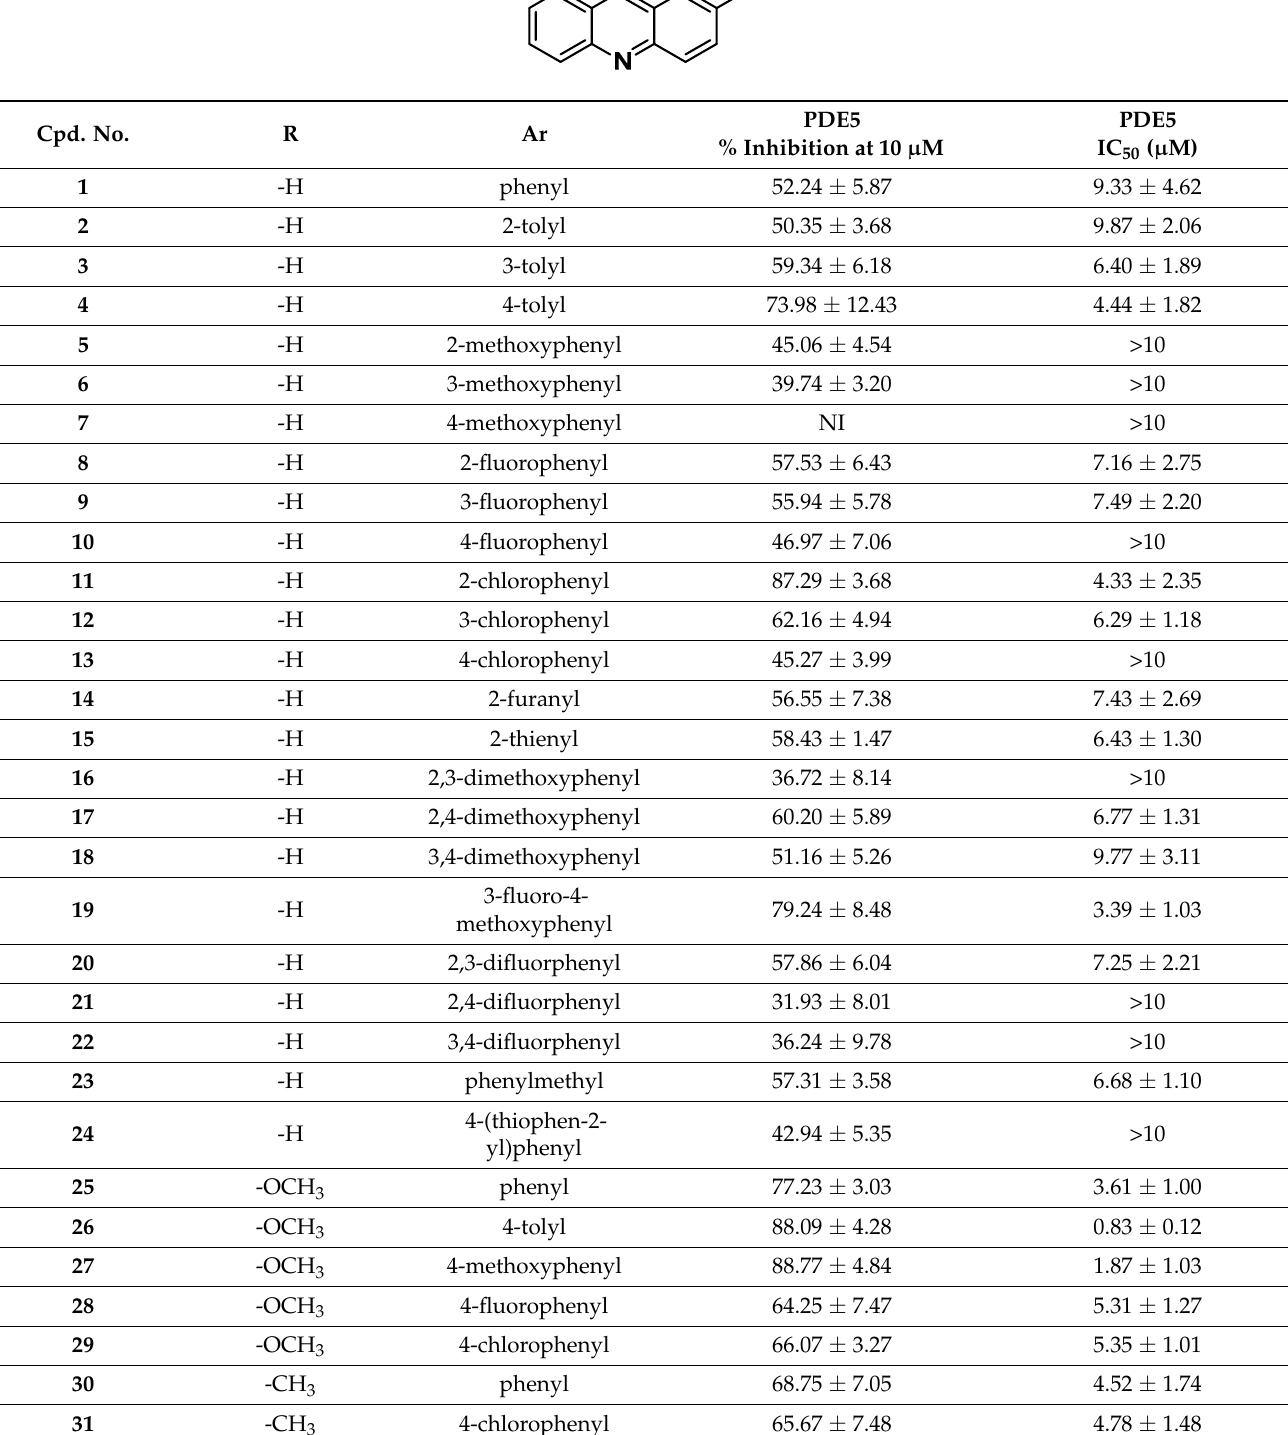
Table 1. % inhibitions of the synthesized compounds against PDE5A, and IC 50 values a .